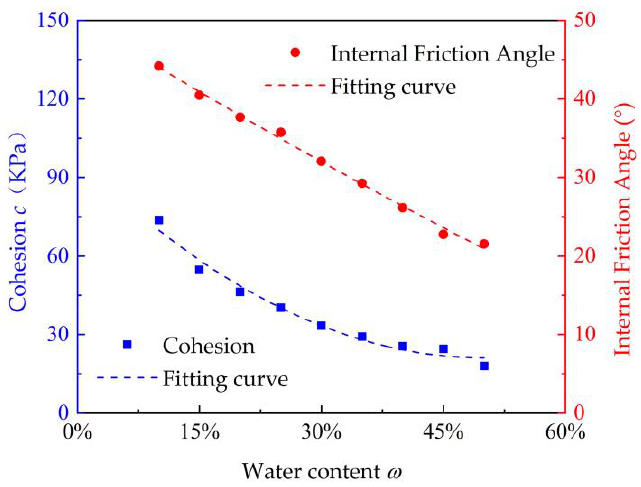
Figure 12. Friction angles and cohesion vary with water content